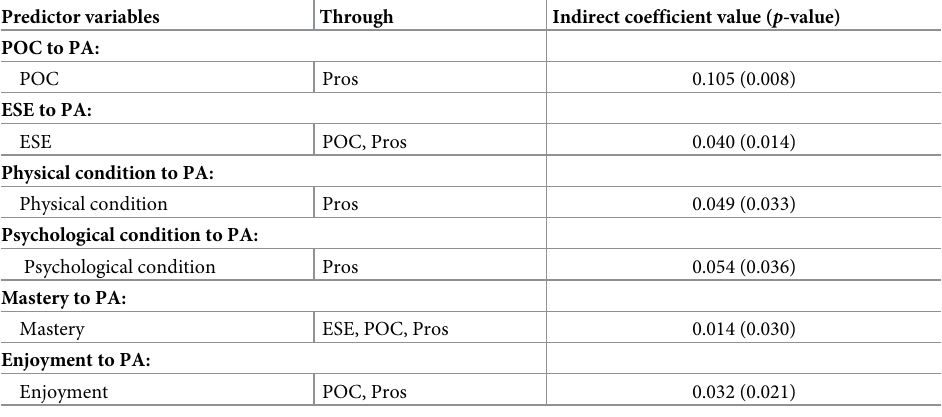
Table 4. Standardized indirect and p-value of the motives for PA and TTM’s variables toward amount of PA. Predictor variables